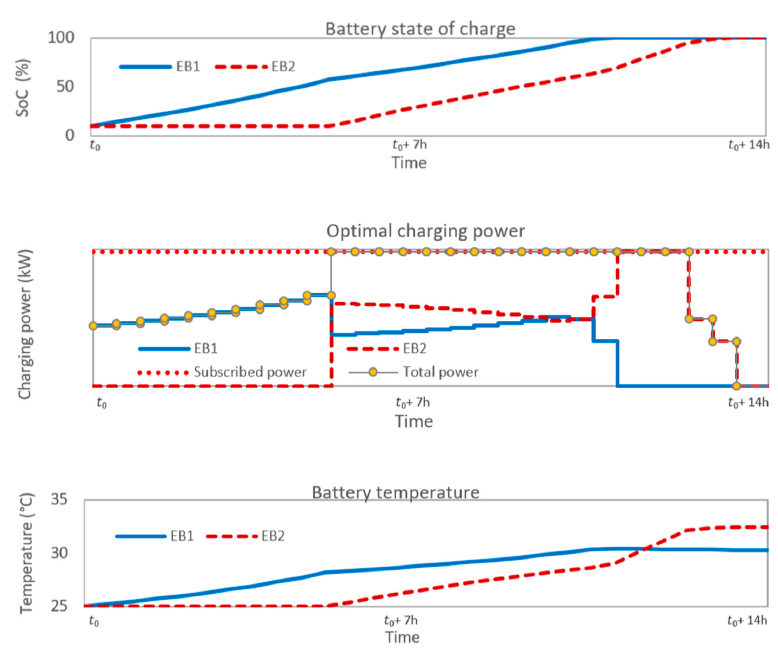
Figure 8. Optimal charging schedules scenario 2.